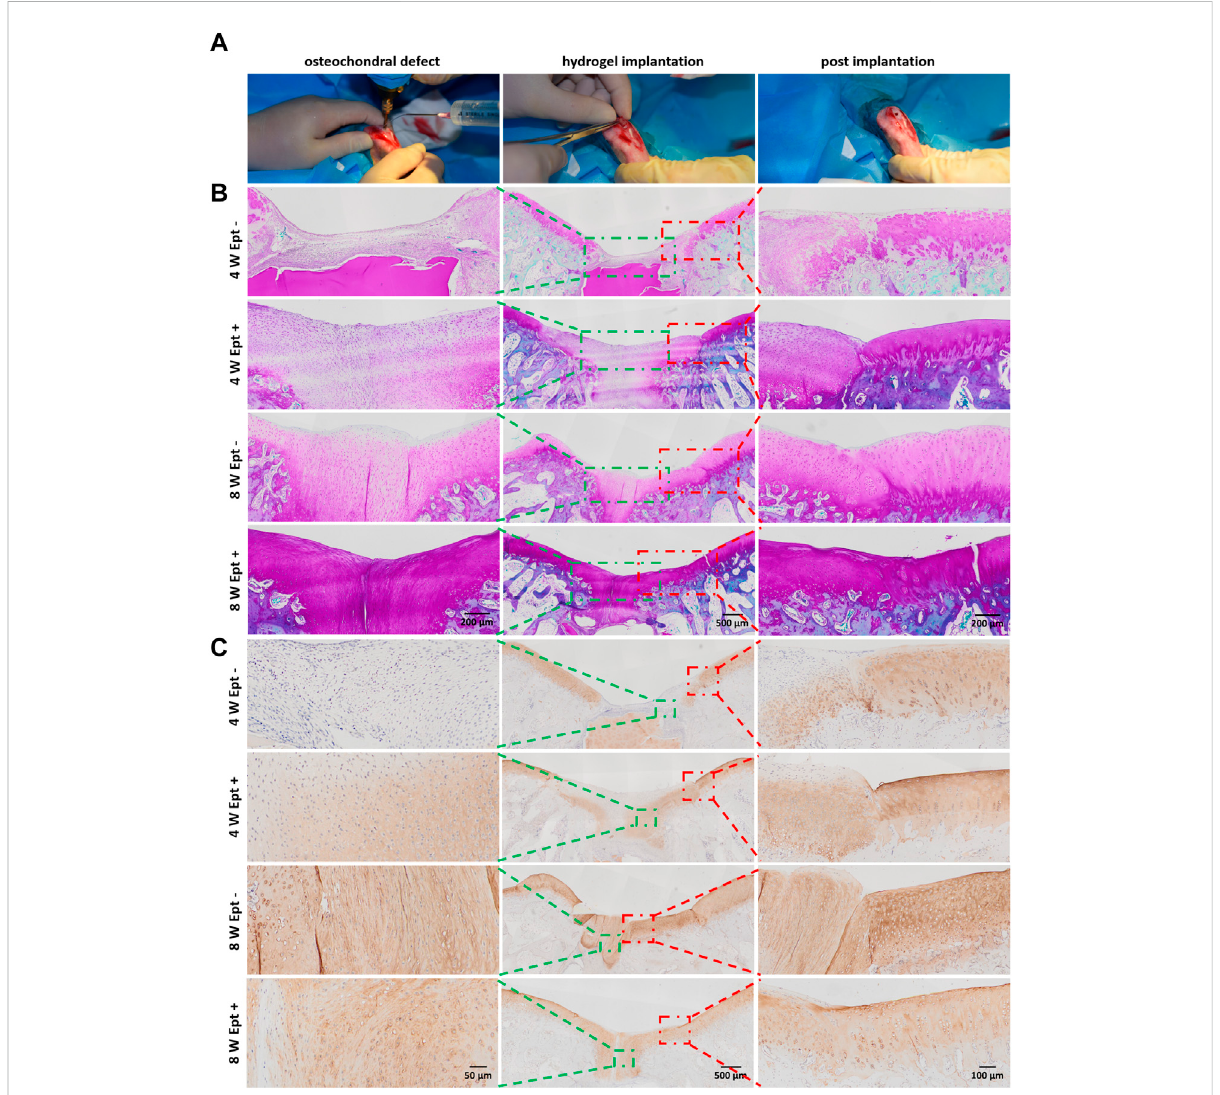
FIGURE 2 Detailedhistologicalanalysis indicatedthat Eptpromoted osteochondralregeneration. (A) The creationprocessofchondraldefectintrochlear groove and implantation of SF/PL hydrogel. (B) Safranin O staining of the knee joints 4 and 8 weeks postoperatively. (C) The immunohistochemical staining against Col II. Green rectangle indicates the center of regenerated tissue, red rectangle indicates the junction between regenerated tissue and adjacent articular